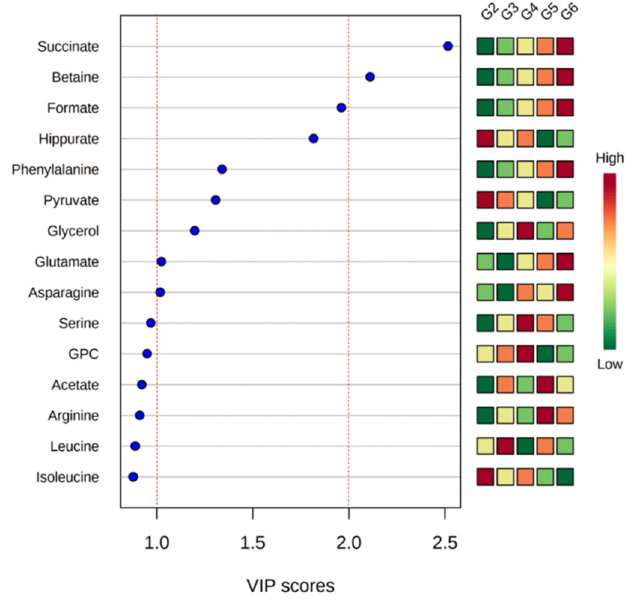
Figure 4. The top 15 metabolites ranked by variable importance in projection (VIP) scores from a comparison of all groups except G1.